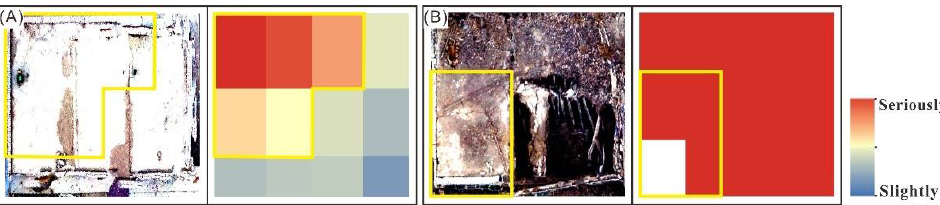
Figure 9. Sample diagram of coherent change detection. ( A ) Lightly damaged building; ( B ) Severely damaged building. The yellow boxes indicate areas that are not correctly